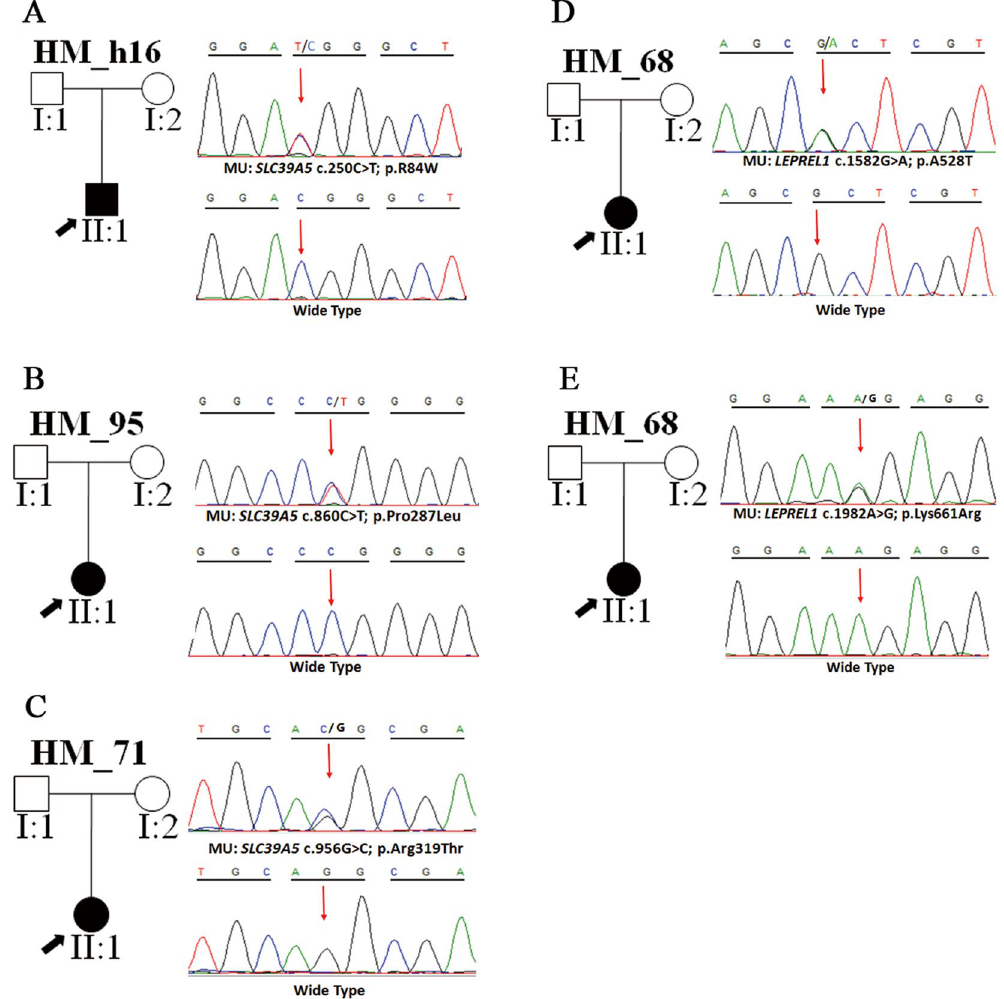
Figure 2. Potentially pathogenic mutations detected in this study. Pedigree plots of mutations. The black arrow represents the patient (left). Sequence profiles of identified mutations and wild type (right) were also shown ( A – E